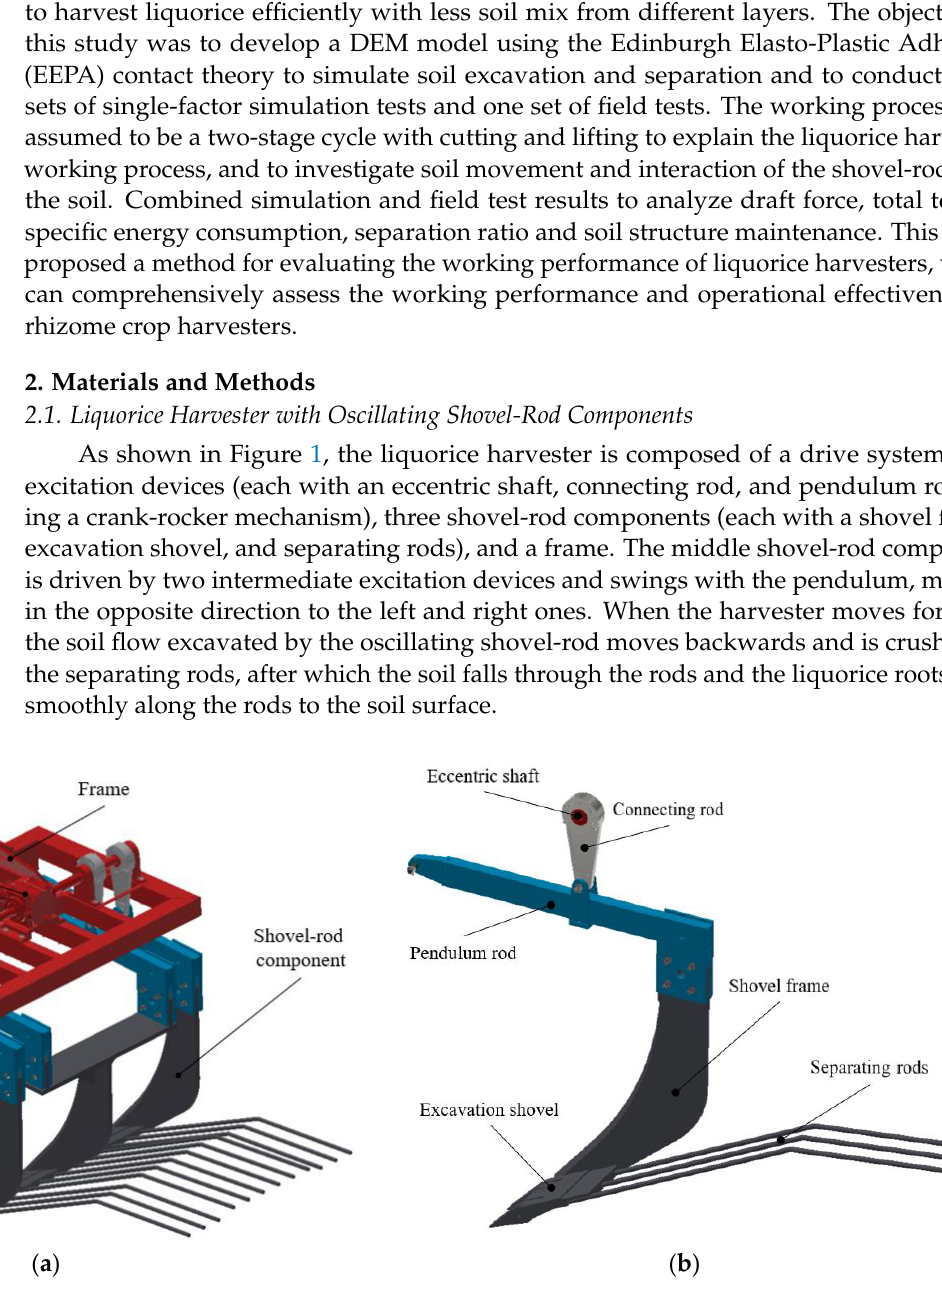
Figure 1. Structure of liquorice harvester. ( a ) Main structure; ( b ) Excitation device and shovel-rod components.